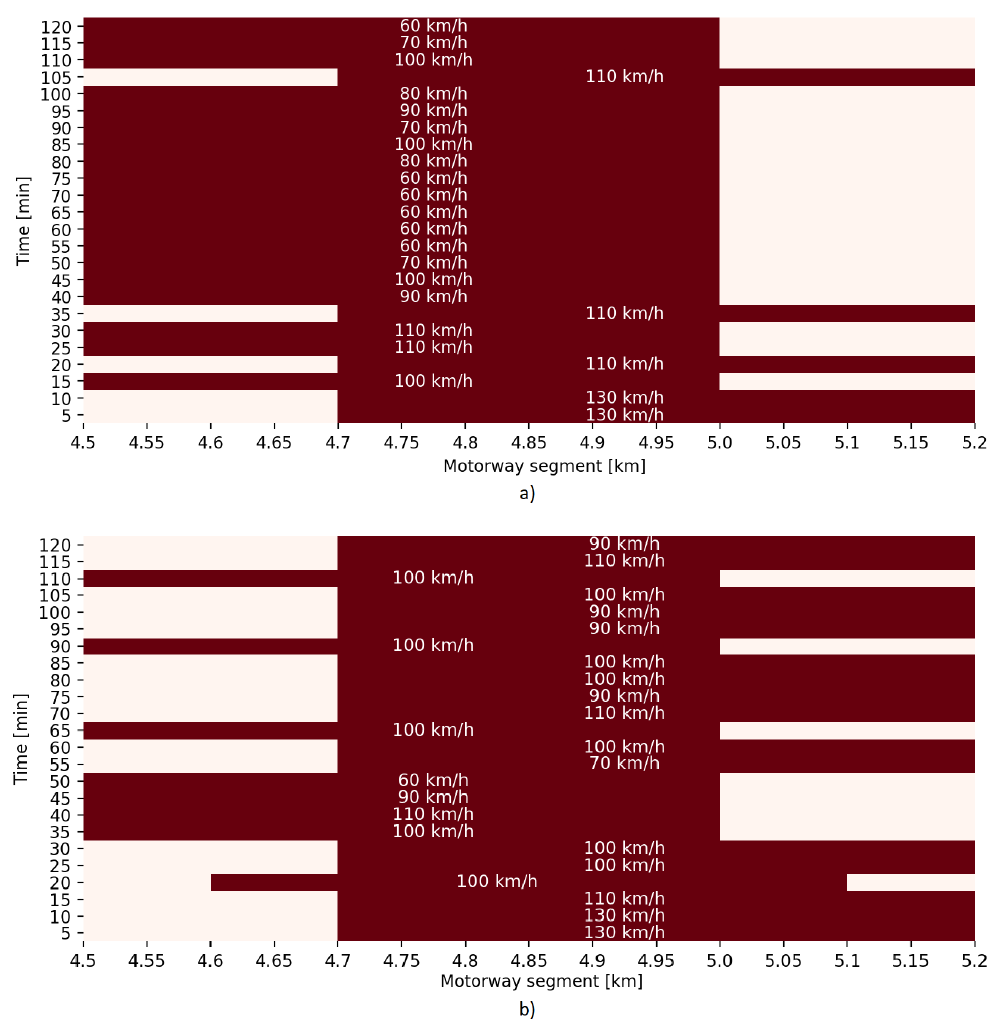
Figure 7. Obtained speed limit zone positions and computed speed limits for scenario 1 ( a ) and scenario 2 ( b